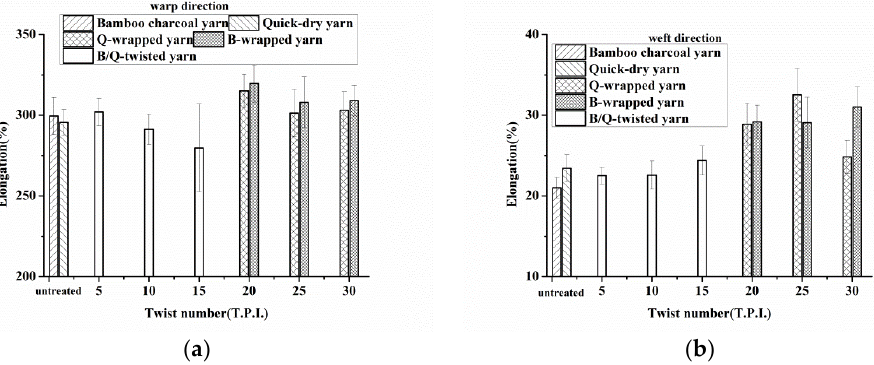
Figure 7. Elongation along ( a ) the warp direction and ( b ) weft direction of functional elastic knits in relation to the administration of a wrapping/twisting process as well as the twist number of the yarns. The error bar indicates the SD.